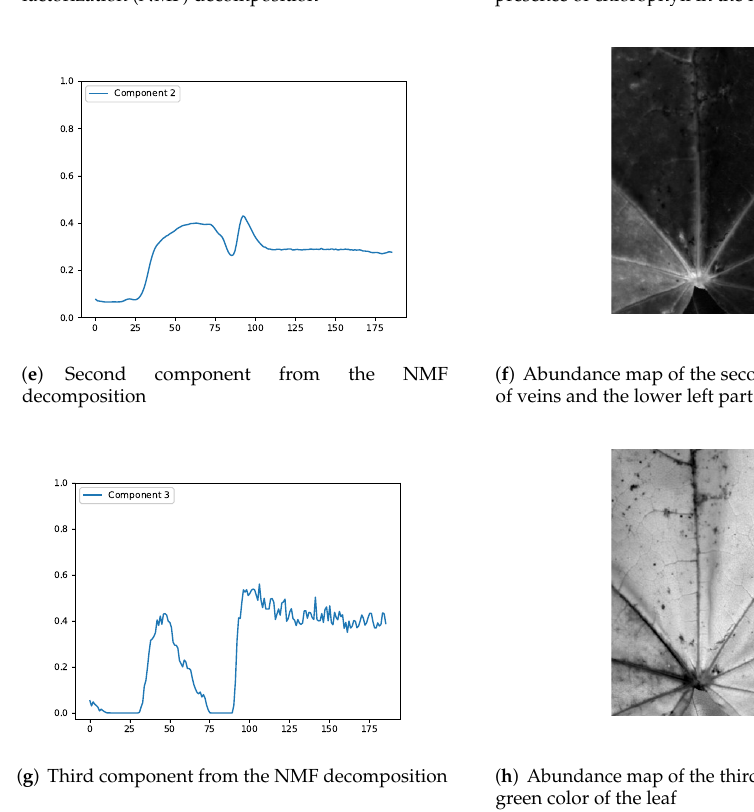
Figure 13. NMF-based decomposition of the vegetation_03_green image in three components. Each component exhibits the spectral composition of leaf, showing the spectra of chlorophyll, veins and the color of the